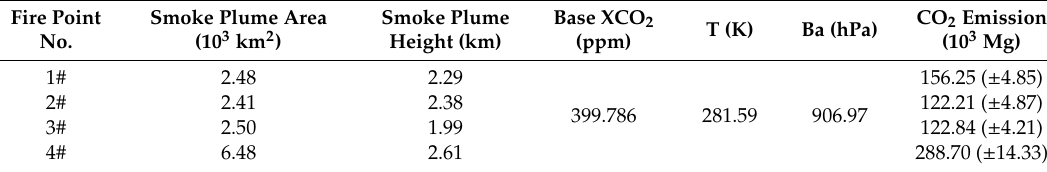
Table 1. CO 2 emission values and calculated parameters for each fire point by